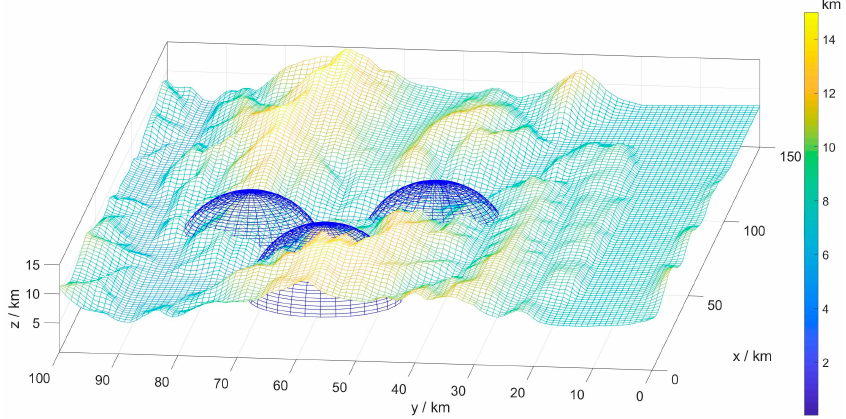
Figure 1. Three-dimensional digital map.